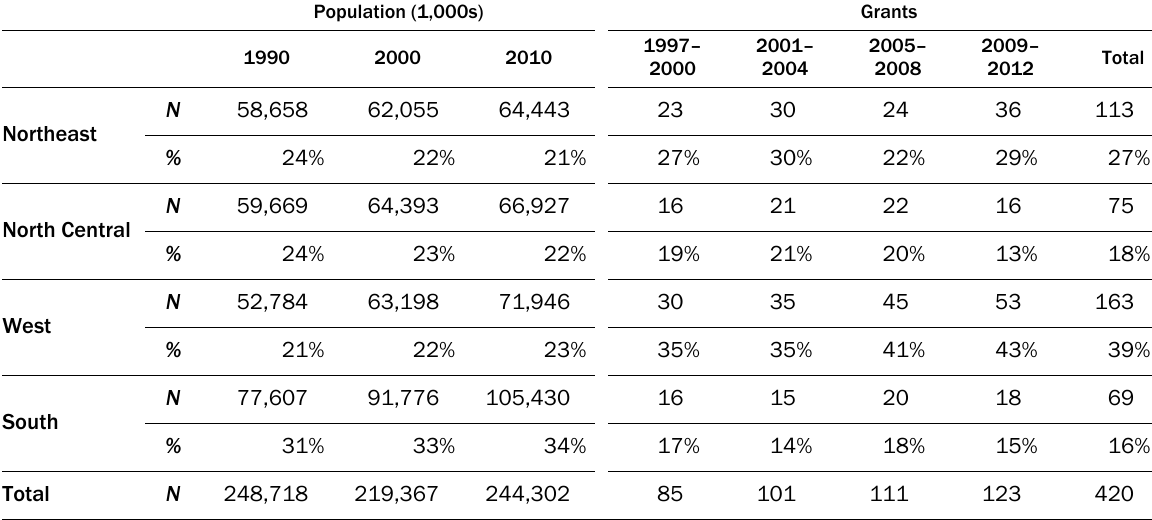
Table 2. Distributions of USDA CFPCGP Grants and Population by Region,